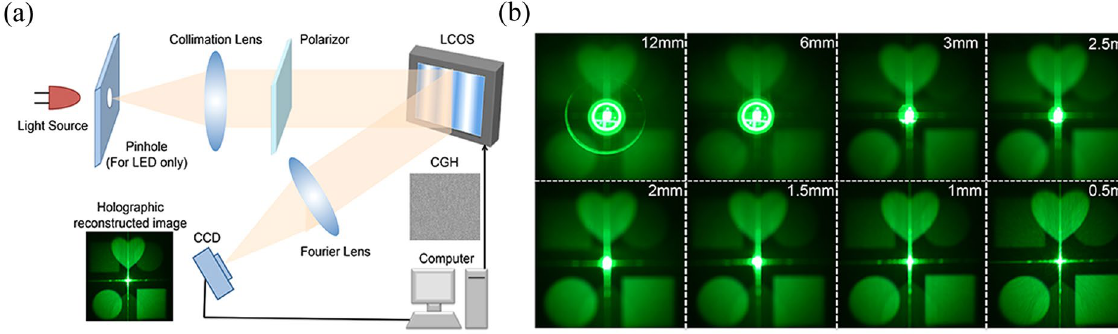
Figure 9. ( a ) Experiment setup for holographic display and ( b ) the holographic reconstructed images based on the same LED used previously with different emitting